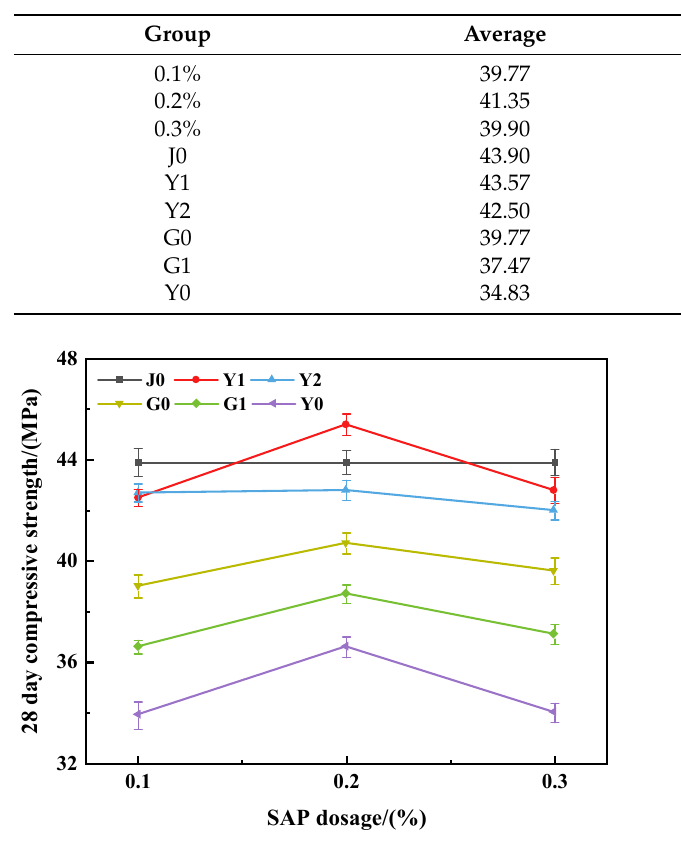
Figure 2. The 28 d compressive strength of